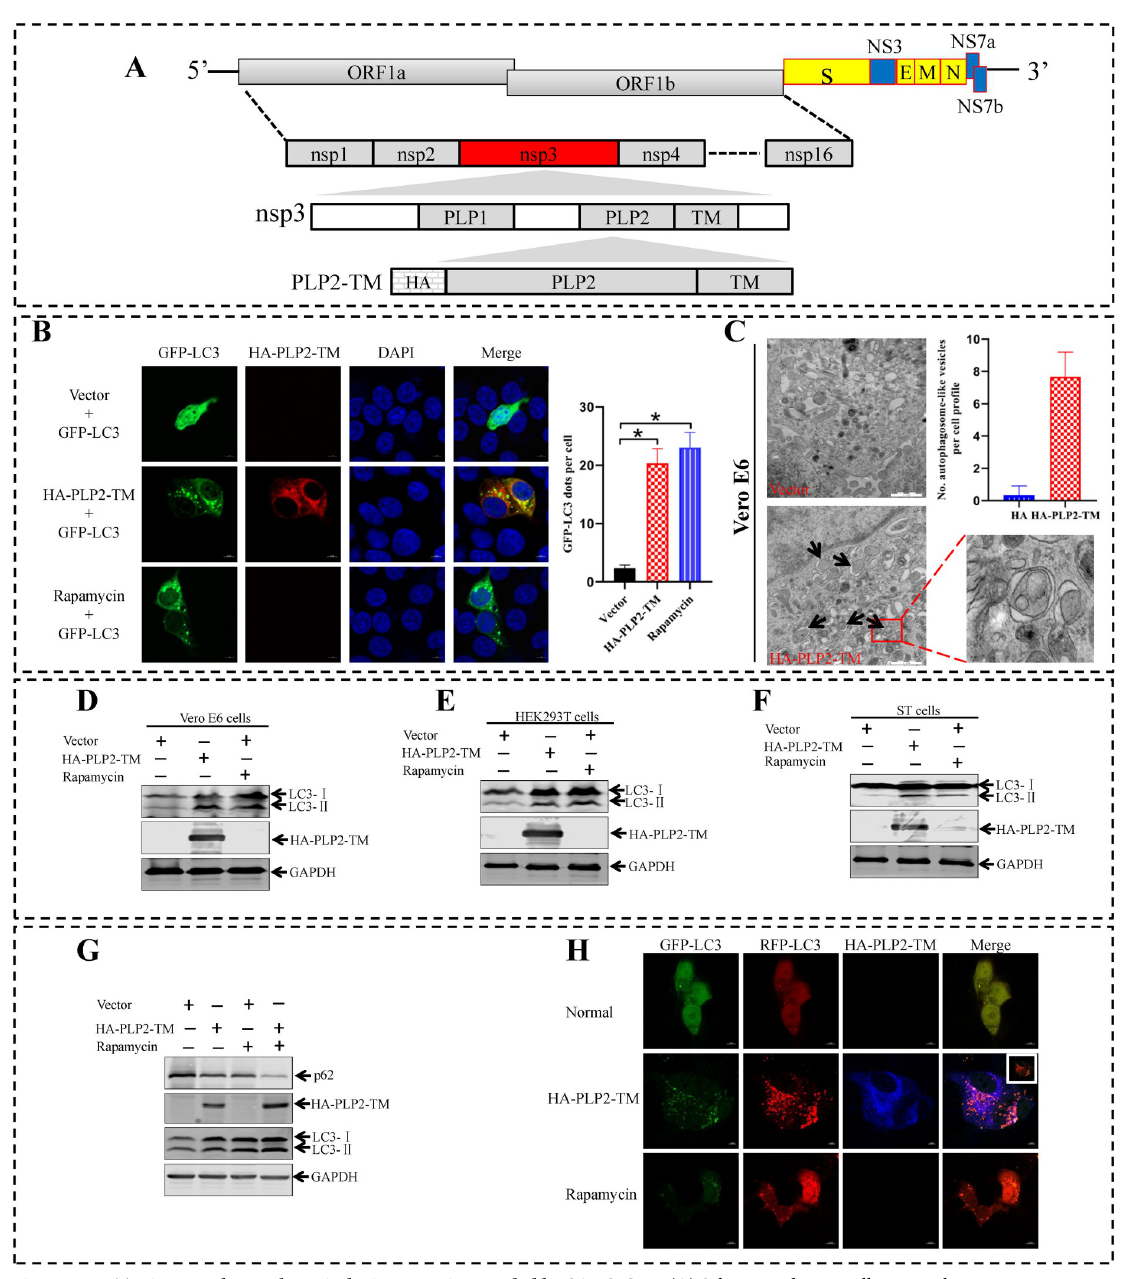
Fig 8. PLP2-TM is a novel autophagy-inducing protein encoded by SADS-CoV. ( A ) Schematic diagram illustrates the coronavirus SADS-CoV genome, polyprotein (pp) 1a/b and the predicted processing of replicase polyproteins (pp) to nsps. The domains, including the predicted transmembrane (TM) domain in nsp3 and the membrane anchored-PLP2 construct (PLP2-TM) used in this study are indicated. ( B ) The HA-PLP2-TM plasmid is co-transfected with pGFP-LC3 into Vero E6 cells. As a positive control for the induction of autophagy, Vero E6 cells are transfected with GFP-LC3 for 24 h and then treated with complete medium supplemented with 250 nM rapamycin for 6 h. The immunofluorescence of cells is detected with confocal microscopy after staining with anti-HA-tagged primary antibody and then with Alexa Fluor 594-conjugated goat anti-rabbit secondary antibody. The localization of GFP-LC3 positive autophagosome accumulation (green) and the HA-tagged PLP-TM (anti-HA, red) are visualized with confocal microscopy. ( C ) SADS-CoV PLP2-TM induces autophagosome-like structures detected with transmission electron microscopy. Vero E6 cells are transfected with pCAGGS-HA or HA- PLP2-TM for 36 h, and then analyzed for autophagosome formation with transmission electron microscopy. Black arrows indicate representative autophagosome-like structures. Scale bar indicates 1 μ m. ( D-F ) Vero E6, HEK293T and ST cells are transfected with HA- PLP2-TM or empty vector for 36 h. The cells are treated with 250 nM rapamycin to serve as a positive control for the induction of autophagy. The expression levels for each protein are analyzed by western blotting analysis with the indicated antibodies (Right panel). ( G )